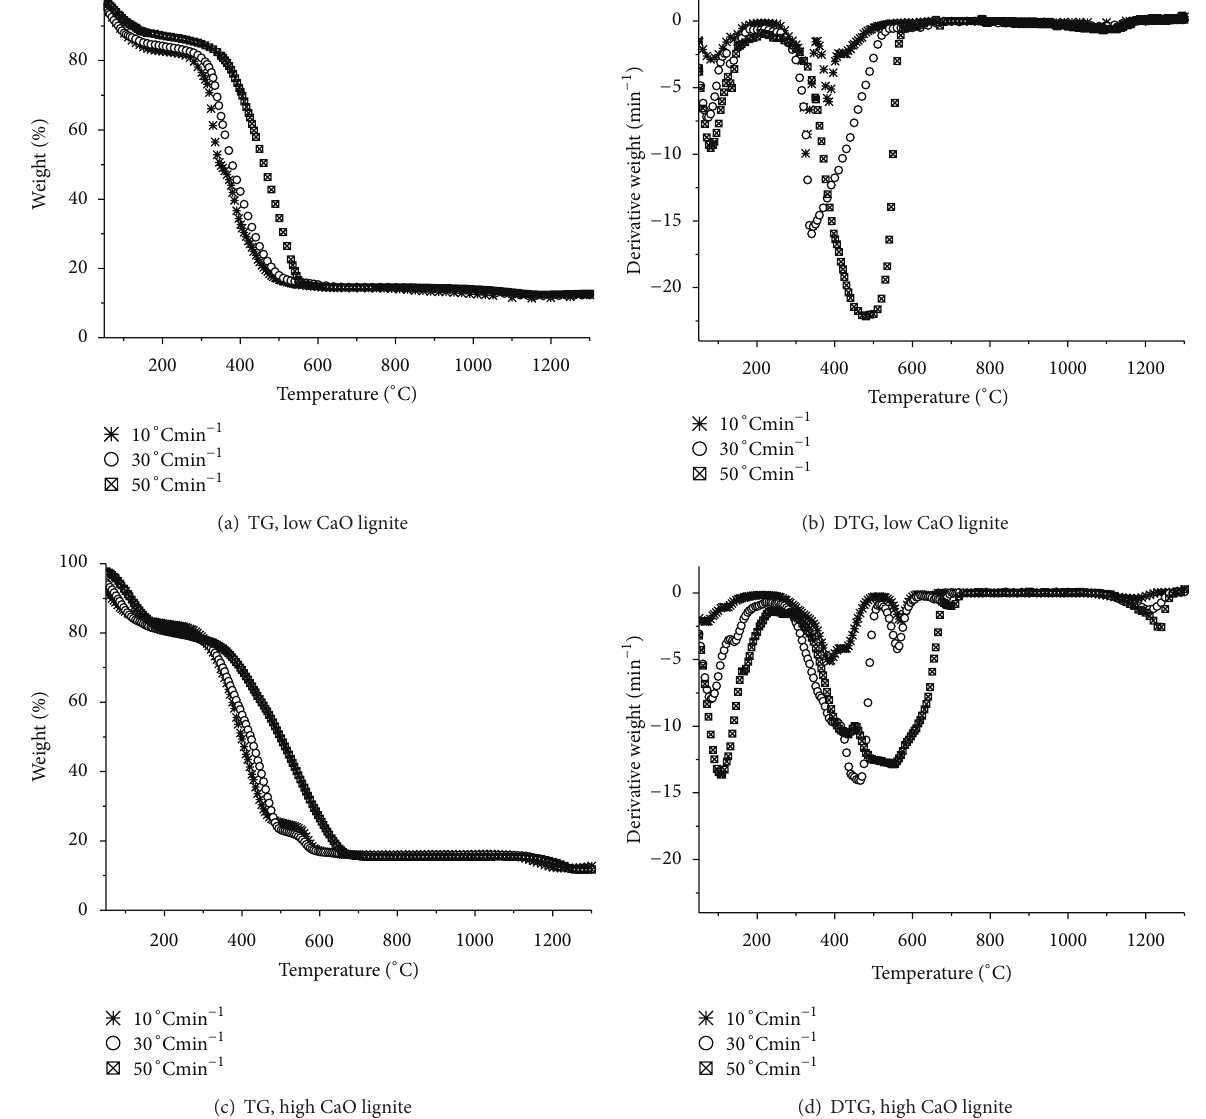
Figure 1: Thermal degradation profiles of low and high CaO samples at different heating